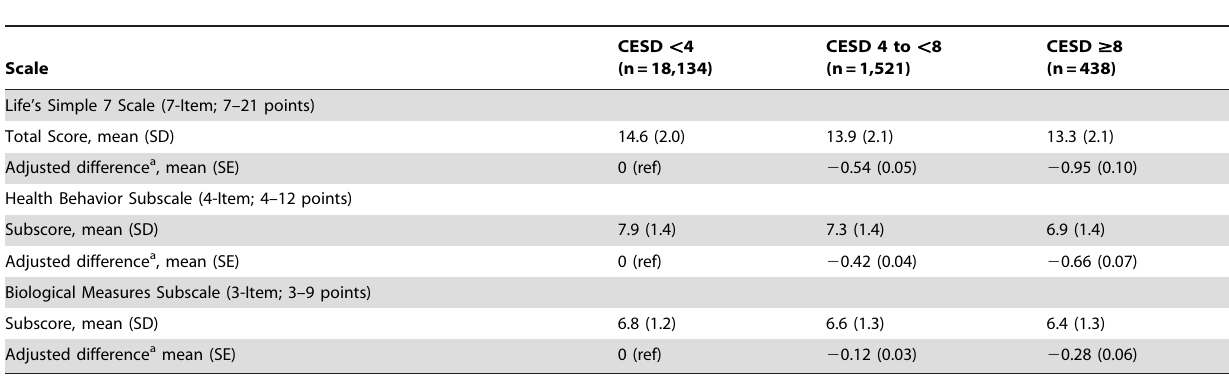
Table 5. Graded Association Between Life’s Simple 7 Total Score and Subscores According to Depressive Symptom Severity.